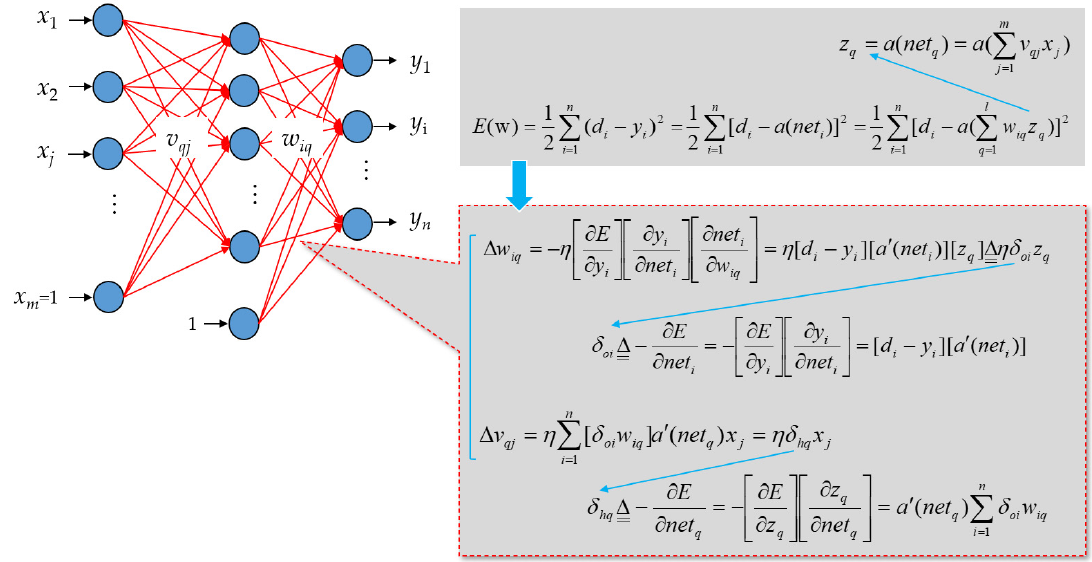
Figure 4. A standard feed-forward and multi-layer ANN as a connectionism mimicking the biologic neural network and consisting of an input layer including at least one hidden layer and an output layer. Usually, the more hidden artificial neurons the neural network has, the more accurate the neural network is.